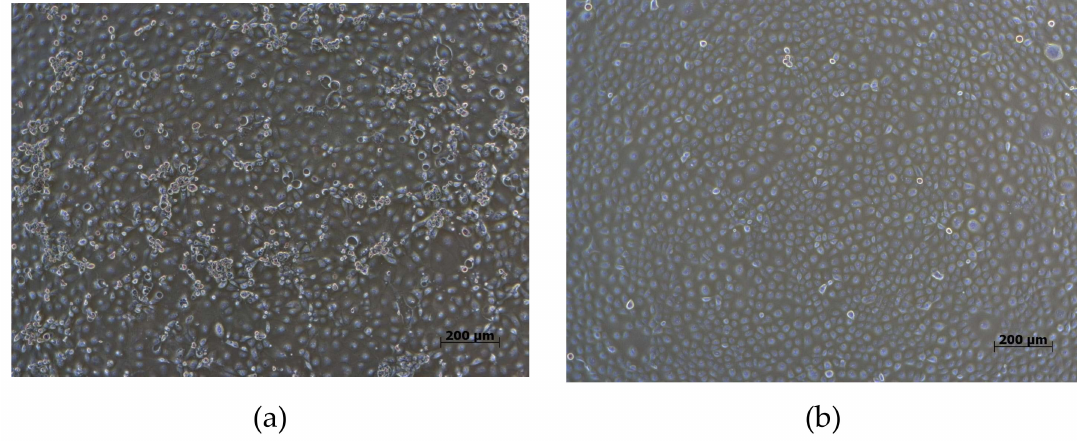
Figure 2. ( a ) Meat Animal Research Center-145 (MARC-145) cells cultured with serum from diseased suckling piglets. ( b ) Uninfected MARC-145